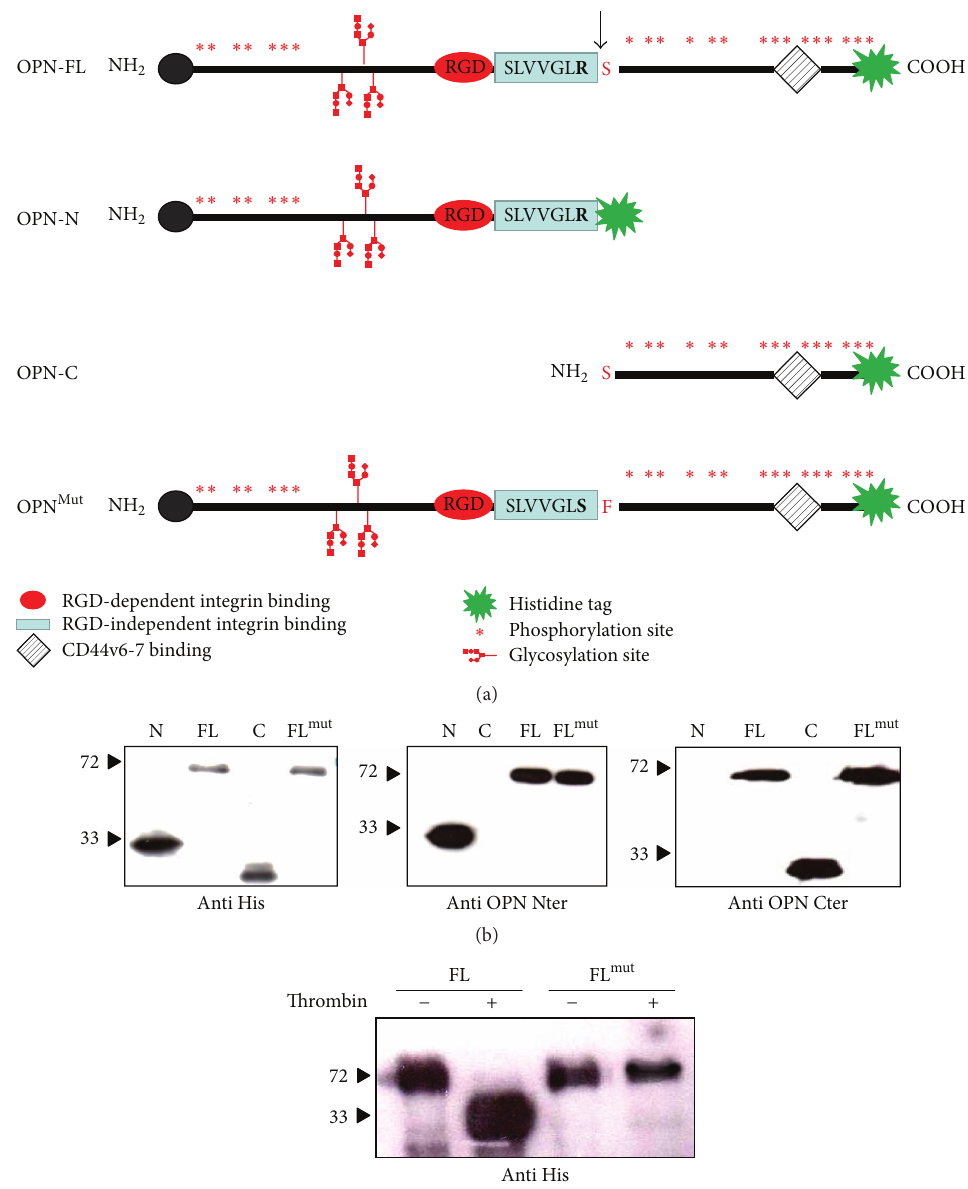
IL-10 was significantly decreased by OPN-FL and OPN-C but not OPN-N (Figure 2(c)). IL-10 and IL-17 expression was evaluated also by intracellular staining of cells restimulated for 5 h with PMA and ionomycin after the 5-day